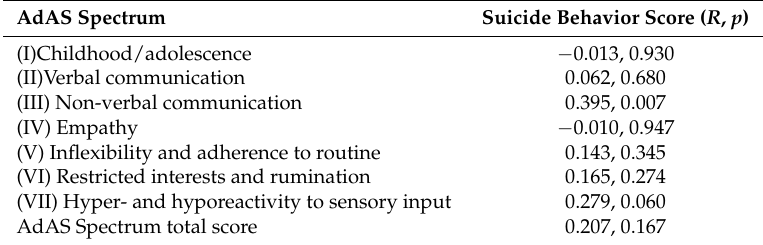
Table 2. Correlation between the AdAS Spectrum domains and total score and the Trauma and Loss Spectrum-Self Report (TALS-SR) suicide behavior score in superior university students with putative PIU.